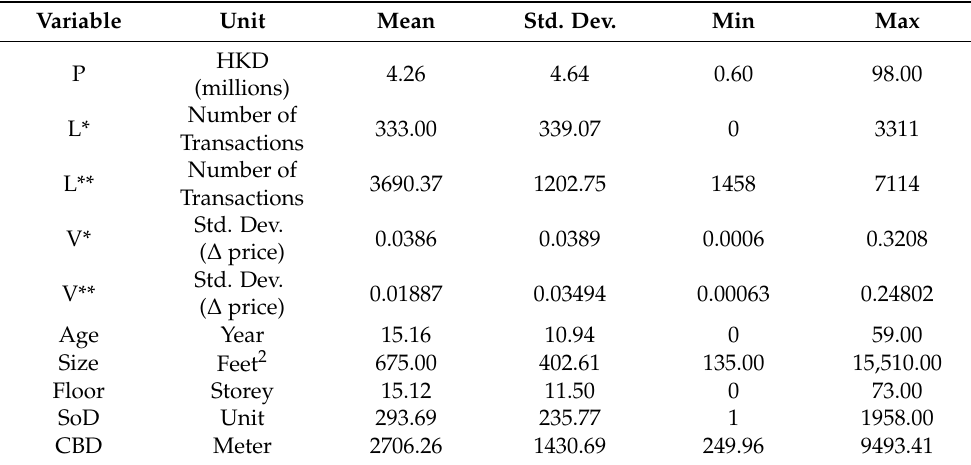
Table 2. Descriptive statistics of the